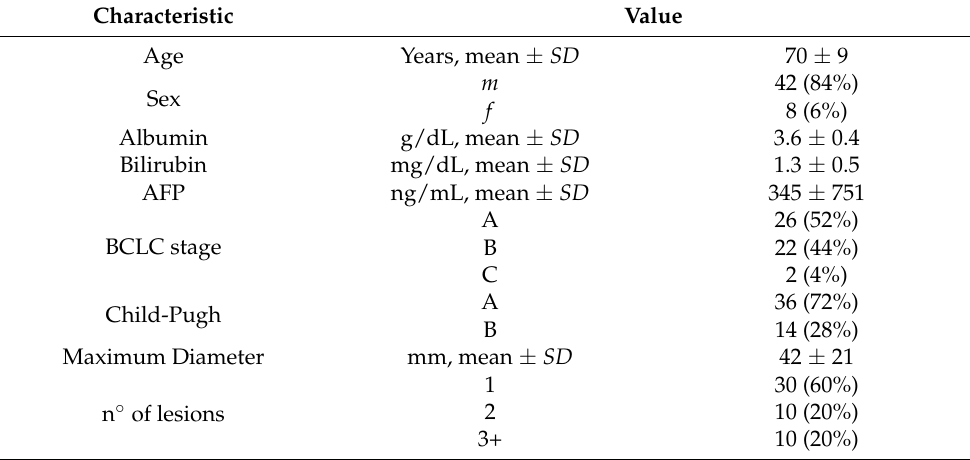
Table 1. Baseline Patient